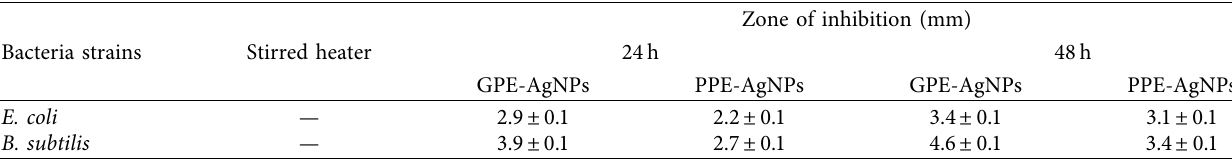
Table 8: Antibacterial activity of GPE-AgNPs and PPE-AgNPs. Bacteria